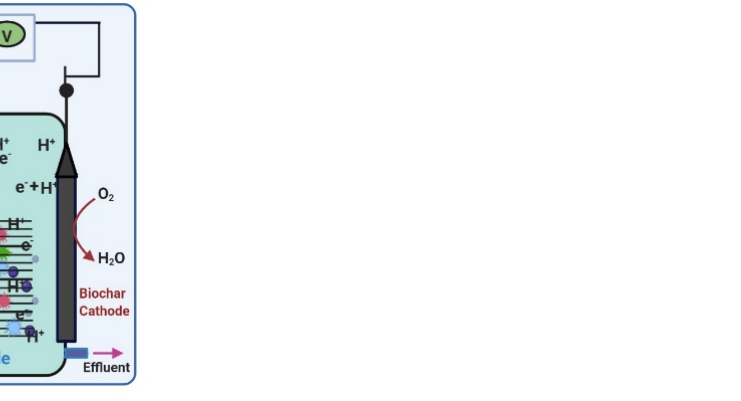
Figure 2. MFC filled with shredded organic residues suspension. B: biochar cathode; RE: reference electrode; A: anode.